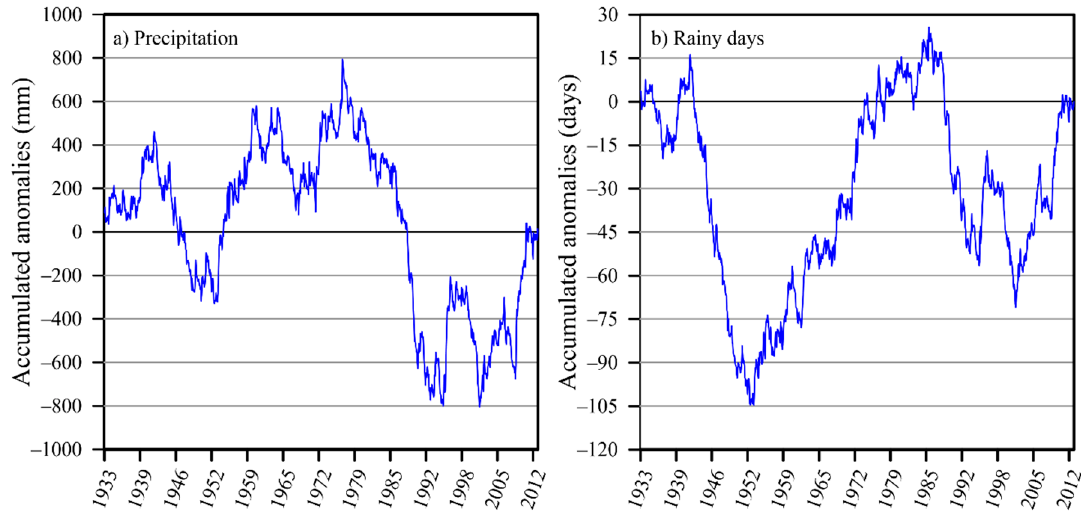
Figure 2. Accumulated anomalies of the monthly precipitation records ( a ) and the number of rainy days ( b ) for the Salento area.